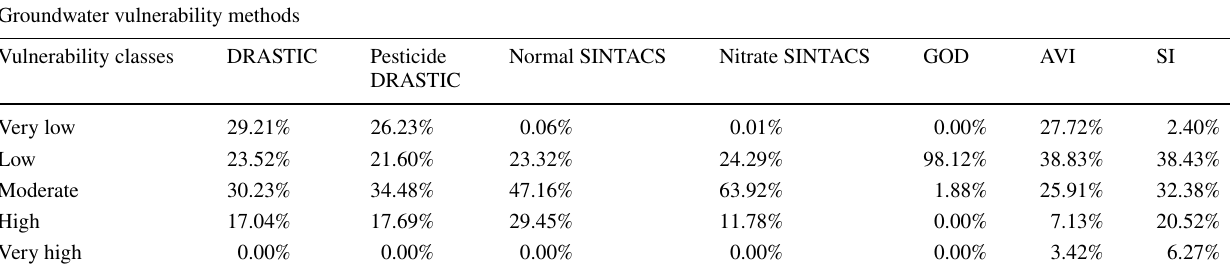
Table 13 Percentage of aquifer vulnerability in seven methods Groundwater vulnerability